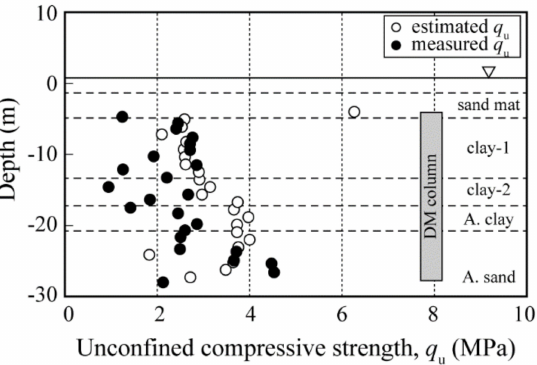
Figure 17. Distribution of predicted laboratory strength and measured field strength along